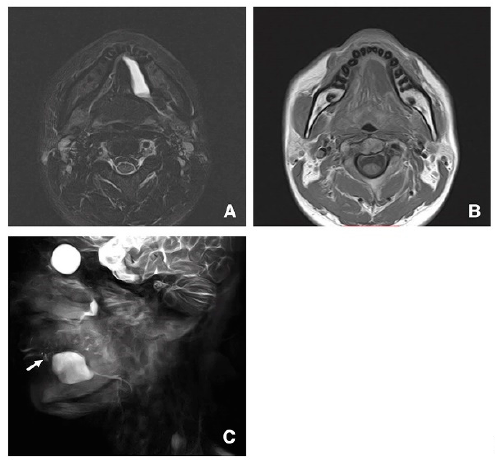
Figure 4. STIR ( A ), T1-weighted image ( B ), and MR sialography ( C ) of a 30-year-old woman with a ranula on the left. The mass lesion is seen in continuity with the sublingual glands in STIR ( A ) and T1-weighted images ( B ) and is diagnosed as a ranula. The mass is derived from one of many sublingual gland ducts (arrow) ( C ).